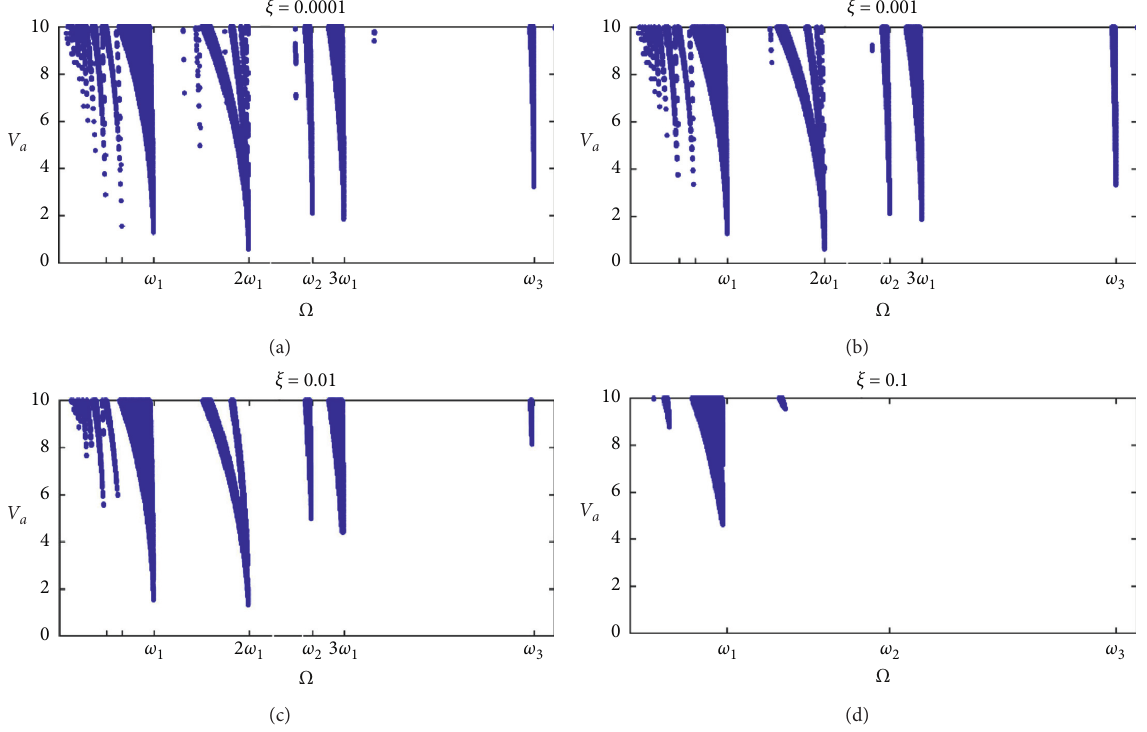
Figure 3: The stabilities of the circular-ring with respect to AC voltage and voltage frequency Ω for different damping ratio. ξ